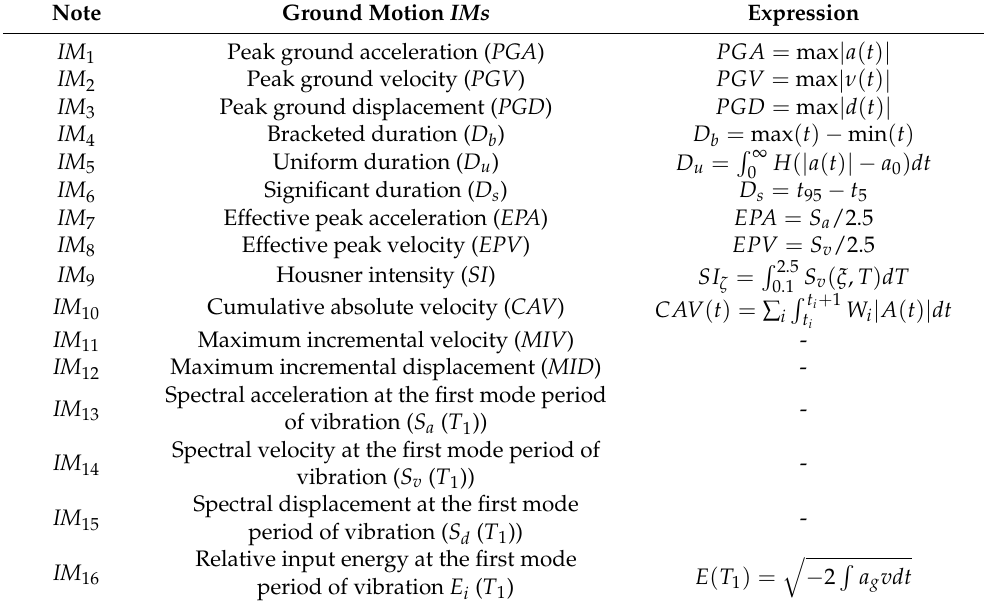
Table 1. Selected IMs.